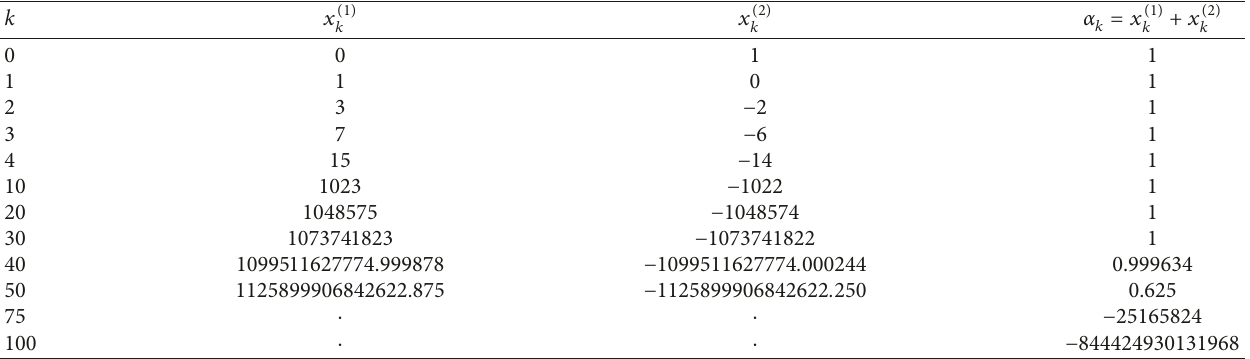
Table 1: Forward computation applied to the gambler’s ruin problem.